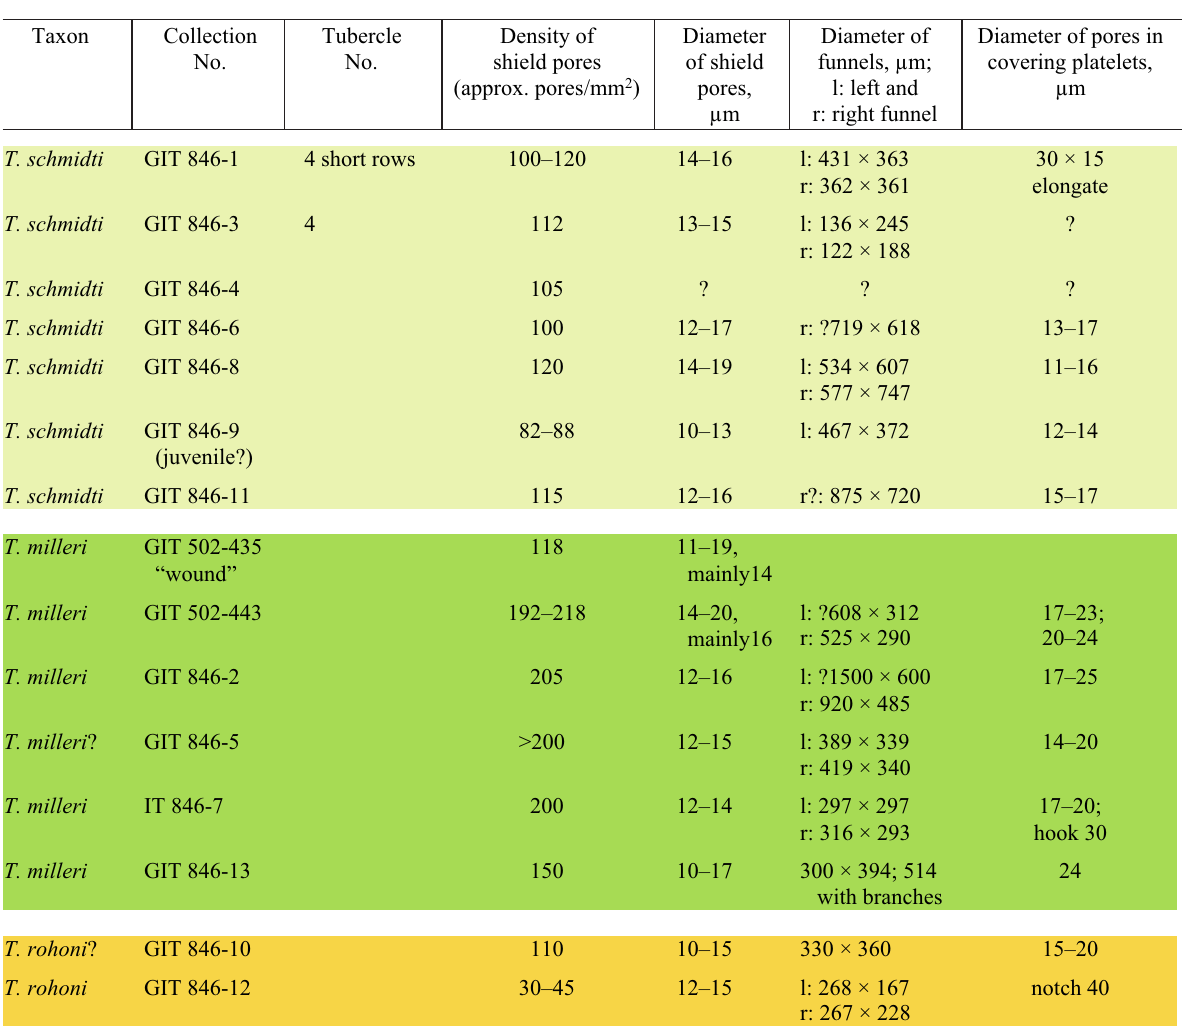
Table 2. Numerical data on headshield pores and pores in covering platelets and funnels of three species – Tremataspis schmidti Rohon , T. milleri Patten, and T. rohoni Robertson. Tubercles were countable in only two